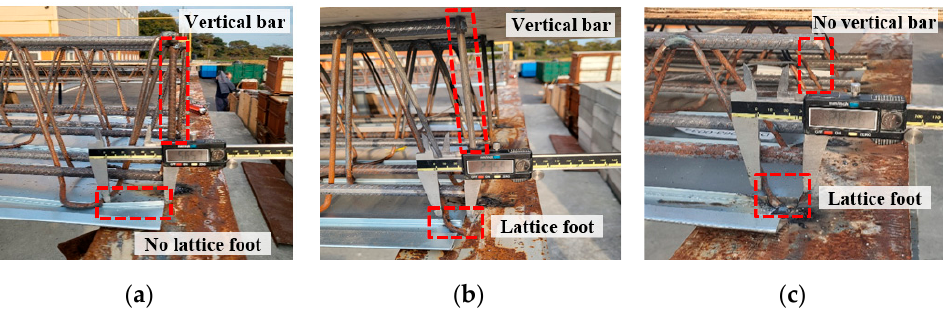
Figure 3. End details of test specimens. ( a ) End detail A. ( b ) End detail B. ( c ) End detail C.